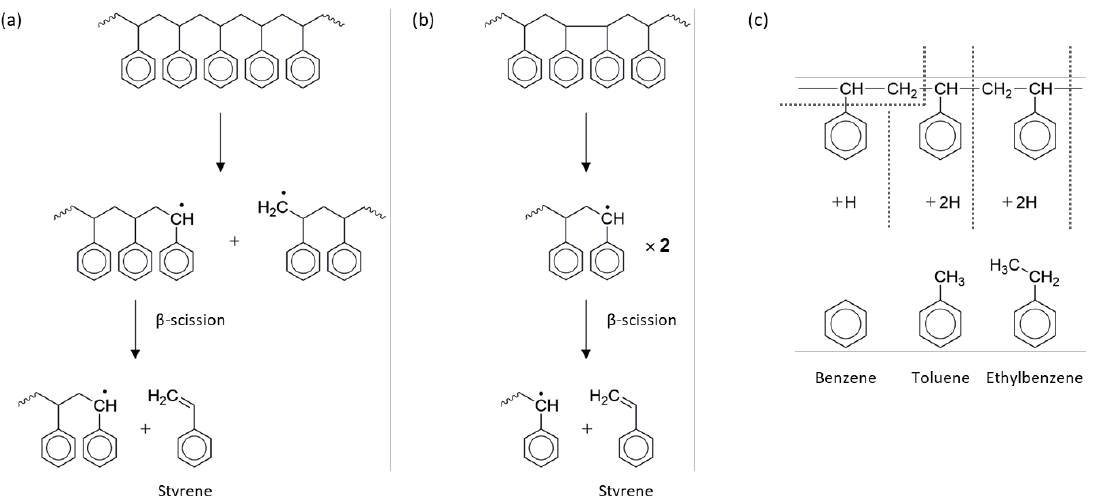
Figure 3. Polystyrene pyrolysis: Random-scission and end-chain β -scission process for styrene formation from ( a ) head-to-tail and ( b ) head-to-head polystyrenes (dominant at lower temperatures); ( c ) plausible processes for the generation of volatile species such as benzene, toluene, and ethylbenzene [27,28].